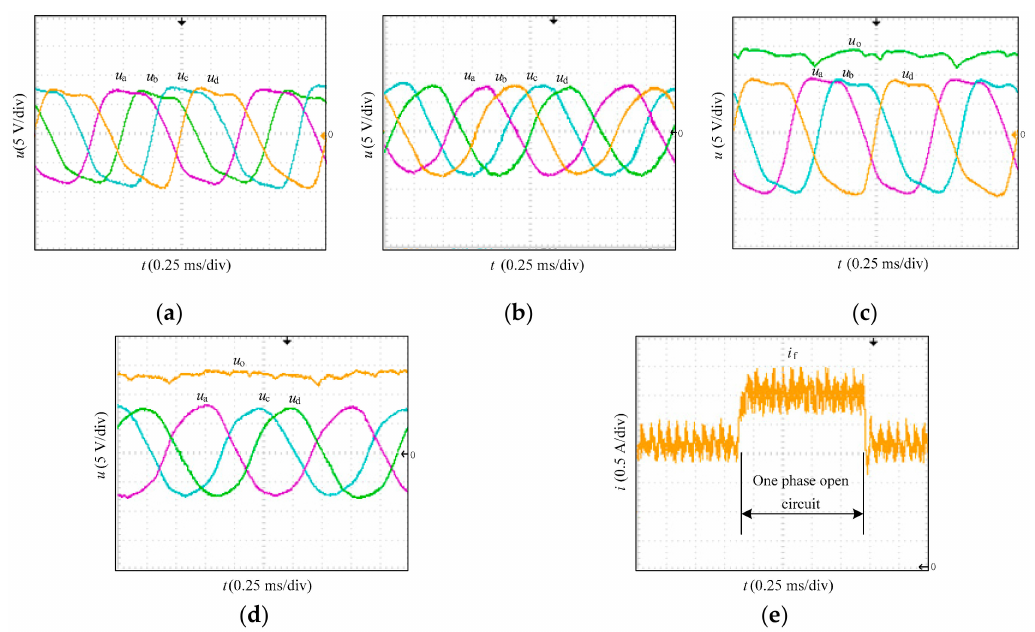
Figure 7. The normal and one phase open-circuit experiment waveforms. ( a ) Normal no-load EMF of the 30 / 24-pole WFDSG; ( b ) normal no-load EMF of the 20 / 16-pole WFDSG; ( c ) no-load EMF with one phase open-circuit of the 30 / 24-pole WFDSG; ( d ) no-load EMF with one phase open-circuit of the